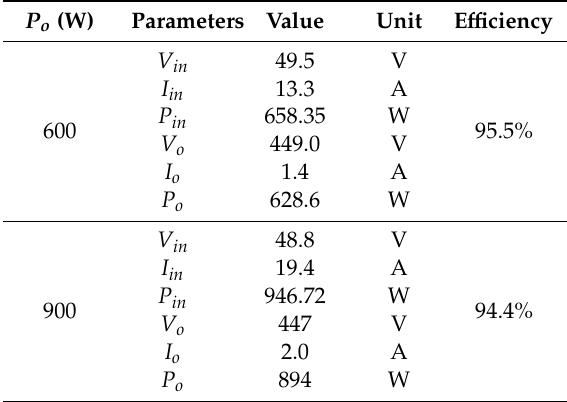
Table 6. Measurement results and the e ff ectiveness of the experiment shown in Figure 7b. P o